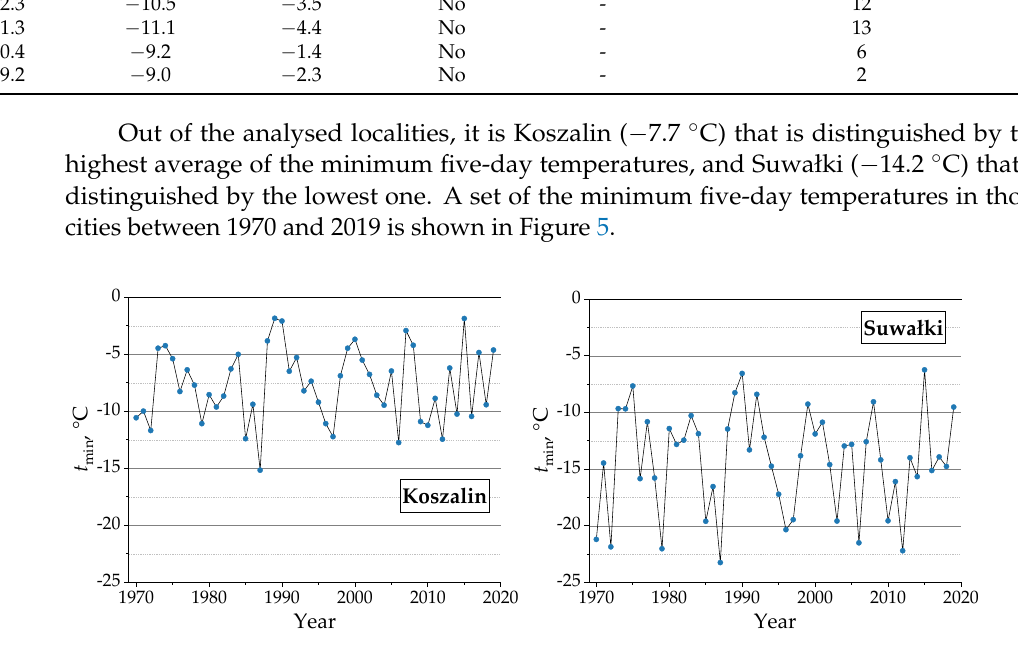
Figure 5. A set of the minimum five-day temperatures in Koszalin and Suwałki between 1970 and 2019.